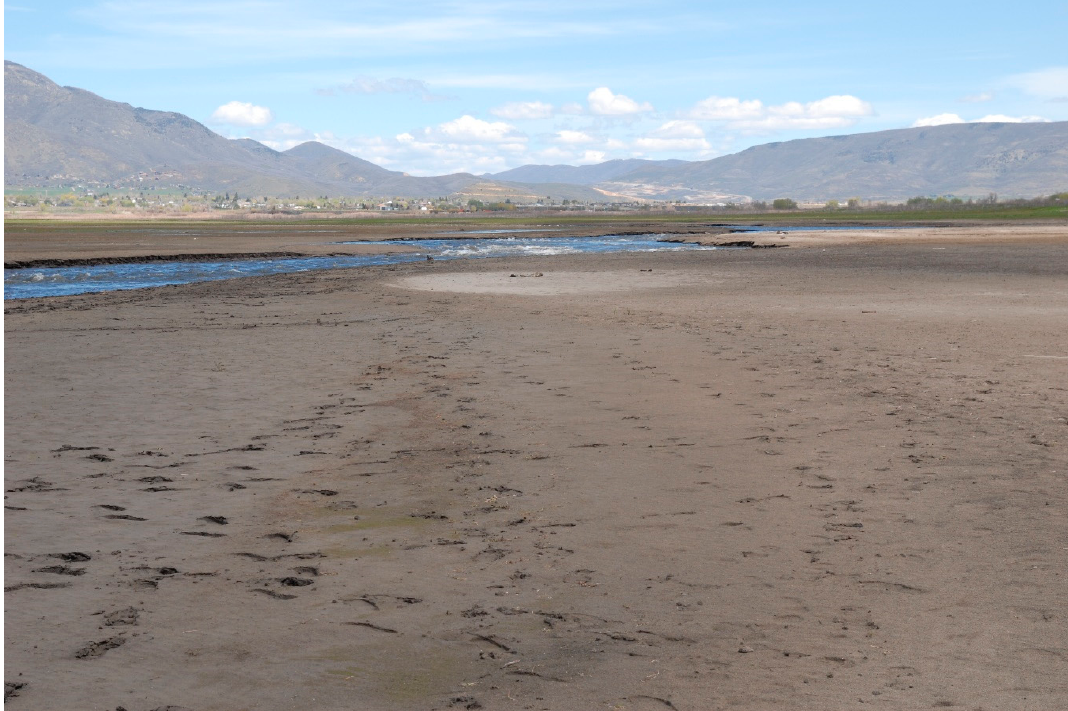
Figure 2. The exposed sediment delta during dam reconstruction showing sediment cutting in the inlet channel. Near the top of the photograph, vegetation can be seen in the portions of the delta that are regularly exposed due to annual drawdowns.